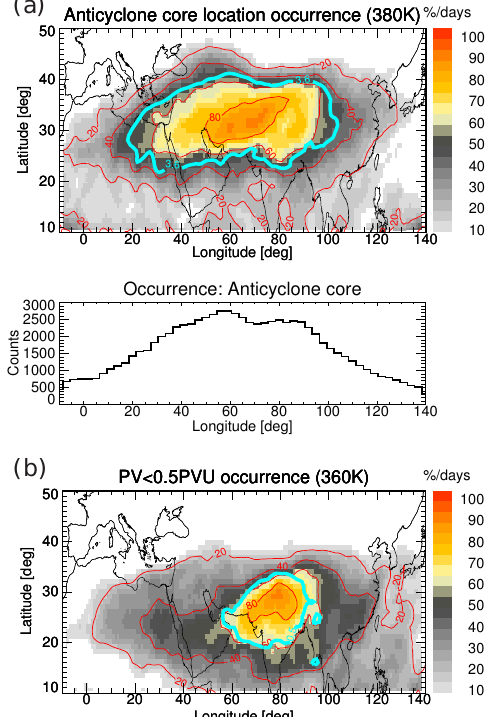
Figure 13. (a) Occurrence frequency of the Asian monsoon anti- cyclone at 380K (in percentage of days) for the period between 20 June and 20 August 2011, calculated from the area covered by PV values lower than the anticyclone transport barrier. Red contours show selected percentage values (20, 40, 60, 80%), the thick cyan contour shows the average PV value of the barrier in the average PV field (average over the period considered). The bottom panel shows the projection of anticyclone occurrence frequency onto the longitude axis (bin size 2.5 ◦ ). (b) Occurrence frequency for PV val- ues below 0.5PVU at 360K isentrope, for the same period (cyan contour shows 0.5PVU in the average PV